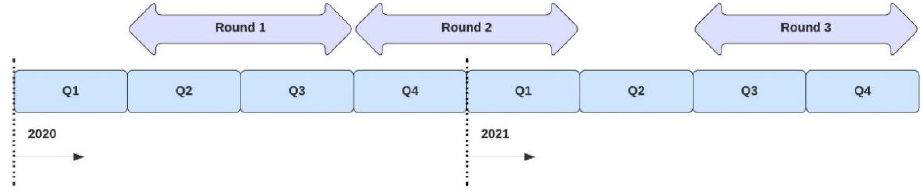
Figure 1. Time coverage of the Pulse